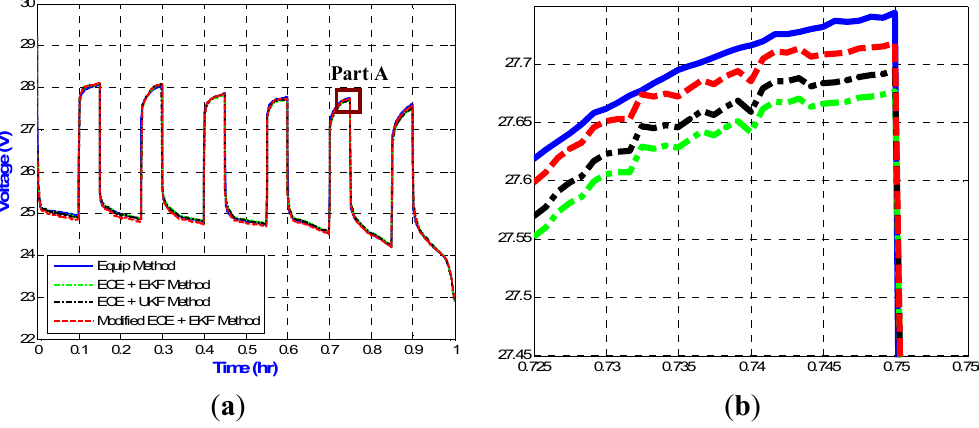
Figure 10. Modeling results in Experiment I. ( a ) Terminal voltage; ( b ) The enlarged Part A of Figure 10a.